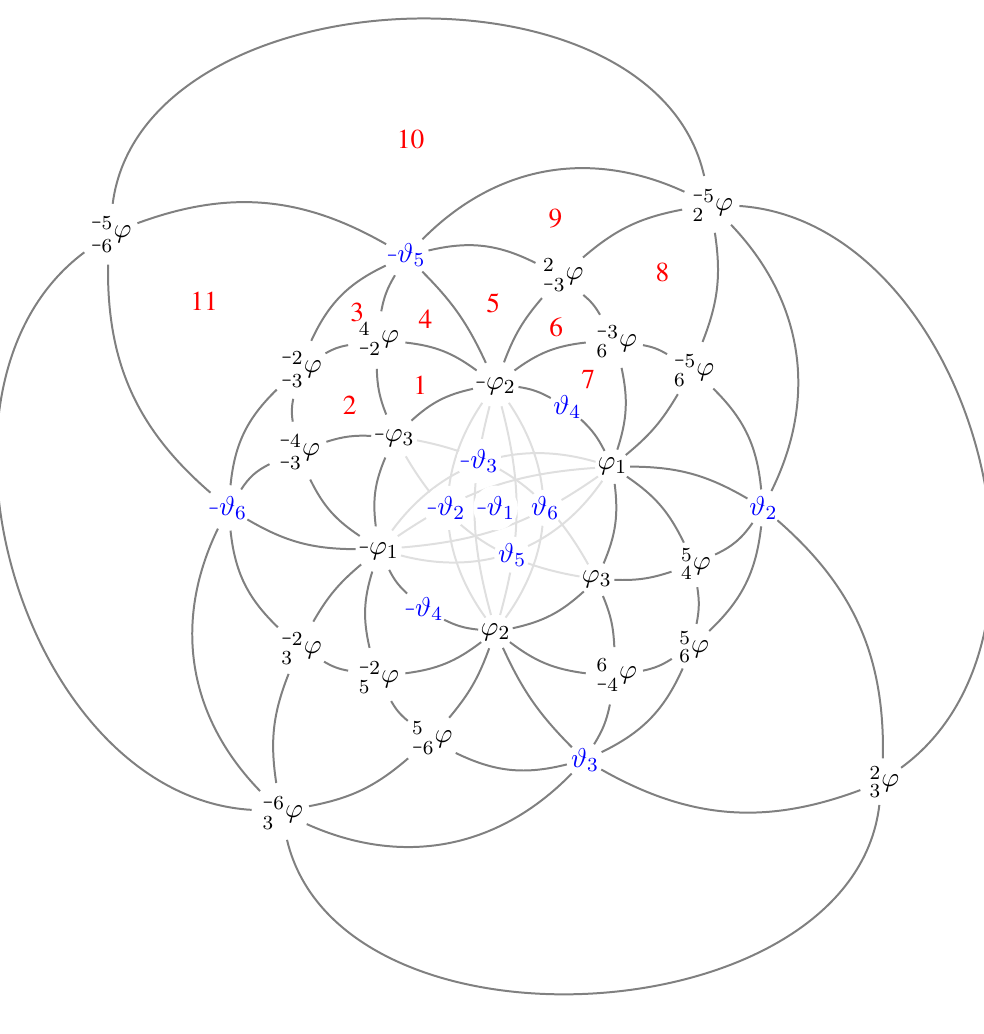
Fig. 13. Topology of the refinement of cylinder boundary intersections ( ϕ k ) induced by the 11 neighbours ( ϑ k in blue) of the central cell. − ϑ k or ϕ k denote ϑ k or ϕ k reflected in the origin, respectively. It has been projected onto the plane from above ϑ 1 .